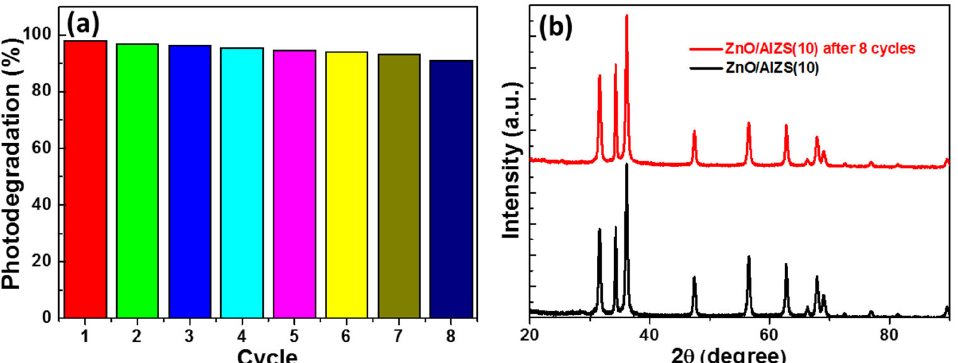
Figure 6. ( a ) Recyclability of the ZnO/AIZS(10) photocatalyst and ( b ) XRD patterns of the native and of the reused ZnO/AIZS(10) catalyst.